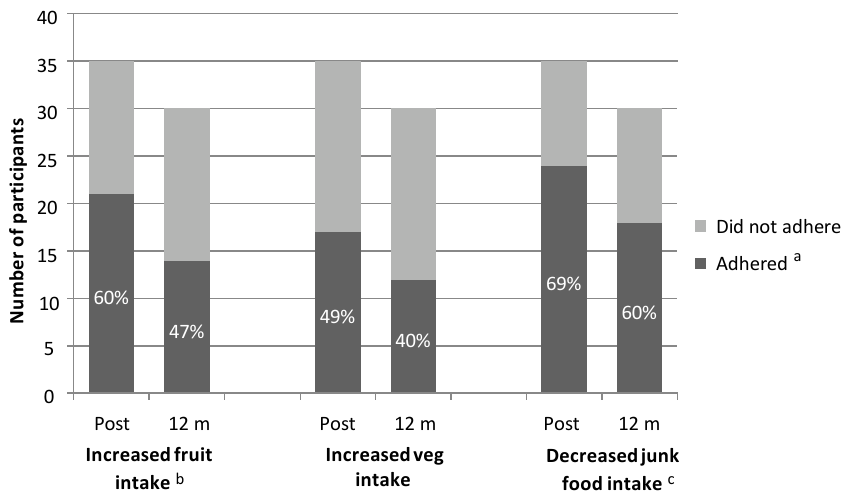
Figure 2. Adherence to the key CAFAP intervention messages regarding increasing intake of fruit and vegetables and decreasing intake of junk food in a group of 35 overweight adolescents. a Adherence data taken from three day food records; b An increased intake was defined as in increase in fruit or vegetable consumption by at least 0.25